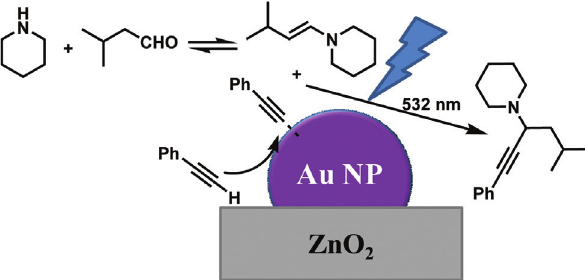
Figure 8 Proposed mechanism for the plasmon-mediated A 3 -coupling of isovaleraldehyde, piperidine, and phenylacetylene catalyzed by AuNP@ZnO, which was irradiated at 532 nm. Redrawn from